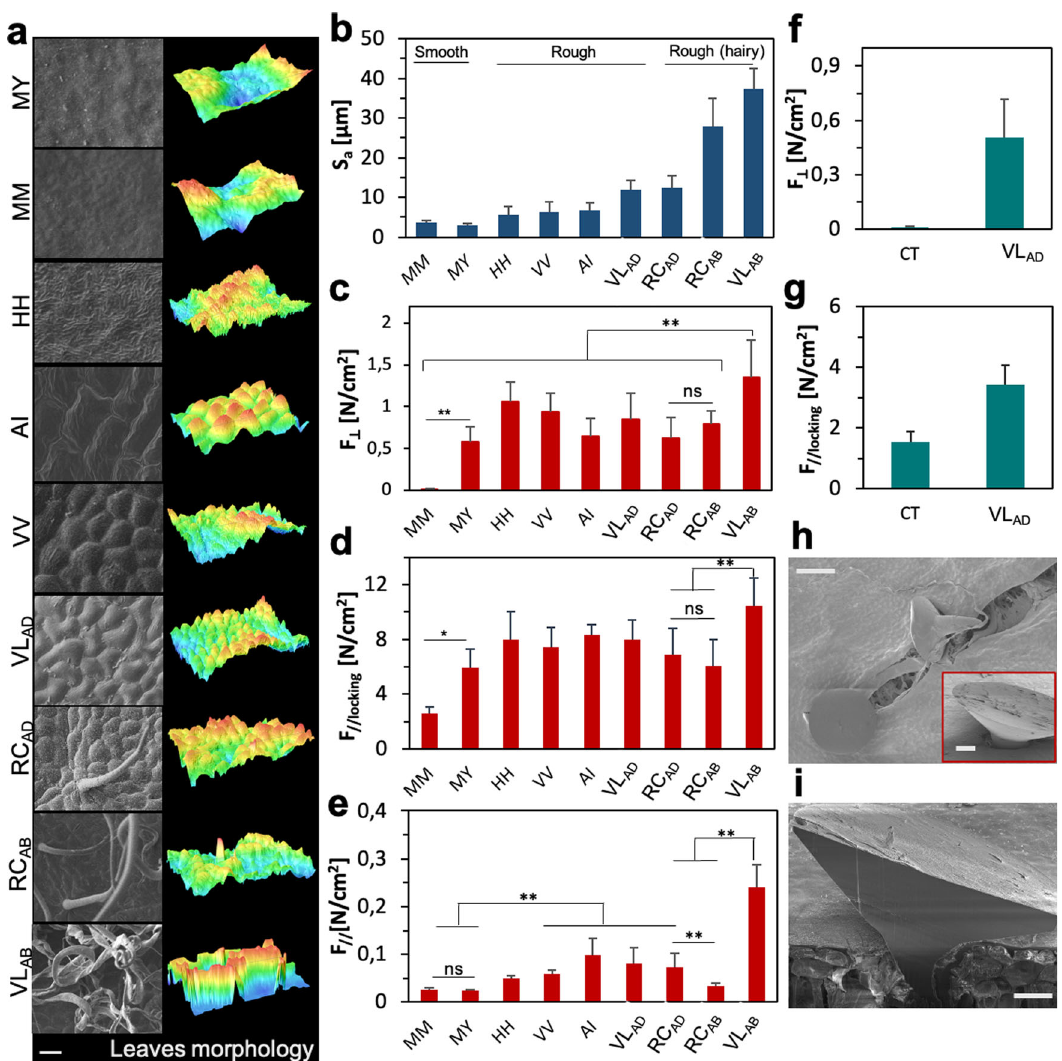
Fig. 2 Structural and mechanical characterization of leaf surfaces and hook interaction. a SEM images (left) and 3D pro fi lometry (right) of leaf surfaces of typical G. aparine host species, including M. grandi fl ora (young and mature smooth adaxial leaf surfaces, MY and MM, respectively), Hedera helix (rough adaxial leaf surfaces, HH), Arum italicum (rough adaxial leaf surfaces, AI), Vitis vinifera (rough adaxial leaf surfaces, VV), Vitis lambrusca (rough adaxial leaf surfaces, VL AD ), Rubus caesius (rough adaxial leaf surfaces with low-density erect hairs, RC AD ), Rubus caesius (rough abaxial leaf surfaces with high-density erect hairs, RC AB ), and Vitis lambrusca (rough abaxial leaf surfaces with helicoidal hairs, VL AB ). Scale bars, 20 µ m. b Average roughness (S a ) of the tested leaf surfaces at ×10 magni fi cation. c, d Maximum pull-off forces (F ⊥ ) ( c ) and maximal shear-locking forces (F //locking ) ( d ) at 1 N preload generated by IPS-MHDs in the interlocking direction on the different tested leaves. The asterisks indicate statistical signi fi cance with p -value > 0.05 (ns), p -value < 0.05(*), or p -value < 0.01(**) (analysis of variance with ANOVA followed from post-hoc Tukey ’ s test). e Friction forces generated by the IPS-MHDs pulled in the direction of hook tip on the various leaves tested. The asterisks indicate statistical signi fi cance with p -value > 0.05 (ns) or p -value < 0.01(**) (ANOVA followed by post-hoc Tukey ’ s test). f, g Maximum pull-off forces ( f ) and maximal shear-locking forces ( g ) generated